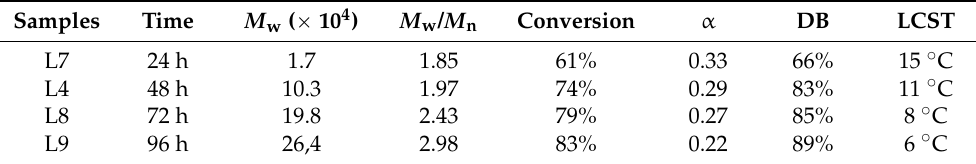
Table 3. Effect of reaction time on polymerization.